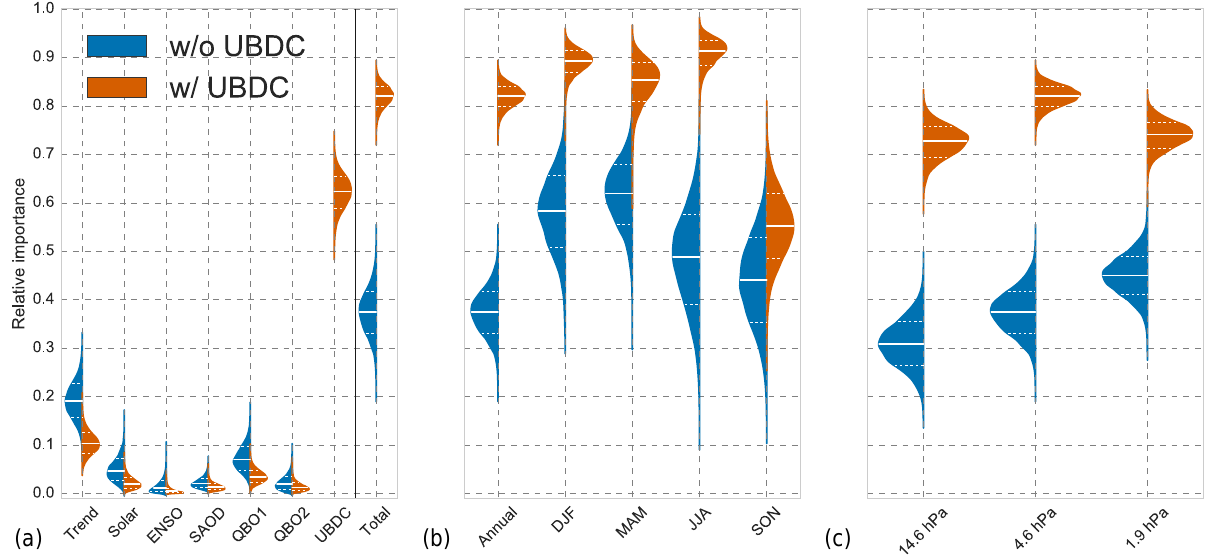
Figure 11. The full distributions of R 2 from MLR of SSU equatorial temperature (20 ◦ S–20 ◦ N, 1983–2005) without (w/o, blue) and with (w, red) the UBDC index showing (a) 4.6hPa R 2 values for all the regressors considered in the analysis, as well as the total; (b) the annual and seasonal total R 2 at 4.6hPa; and (c) the annual total R 2 for the three SSU pressure levels. Distributions were calculated from 10000 bootstrapped samples for each of the possible ( n = 6) 720, or ( n = 7) 5040, order of regressors. Solid white lines are the median values; dotted lines are the 68% confidence